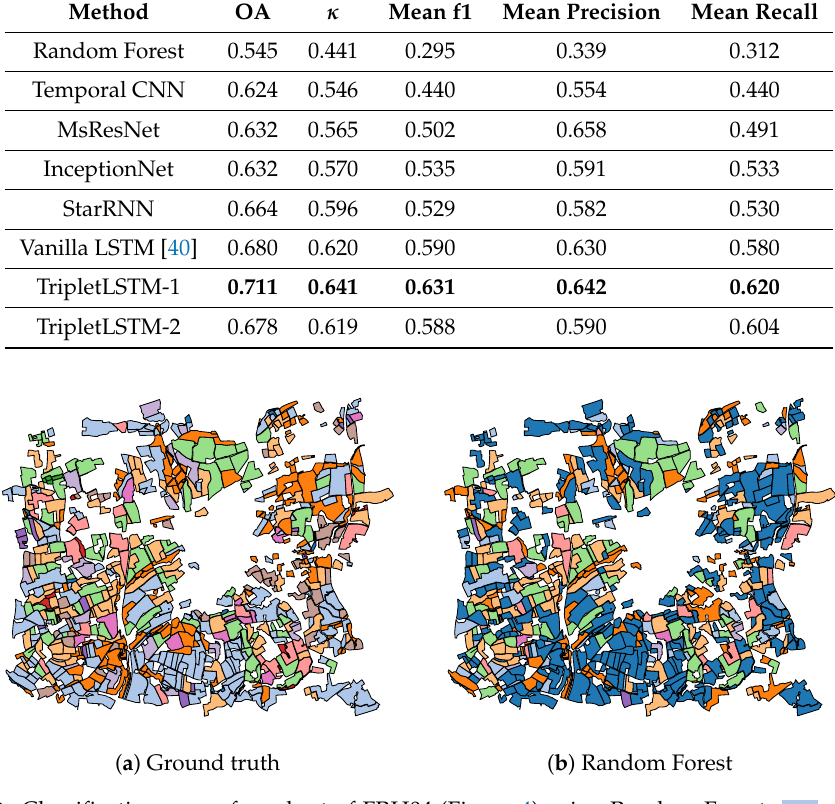
Figure 9. Classification map of a subset of FRH04 (Figure 4) using Random